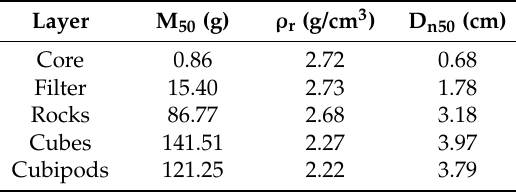
Figure 3. Cross-section of the of the breakwater model (dimensions in centimeters). Table 1. Characteristics of the materials used in the experiments.